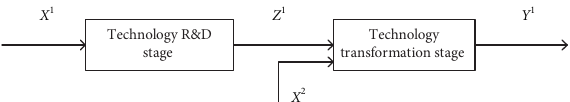
Figure 1: Green innovation activity model (referring to the two- stage model mentioned by Chiang